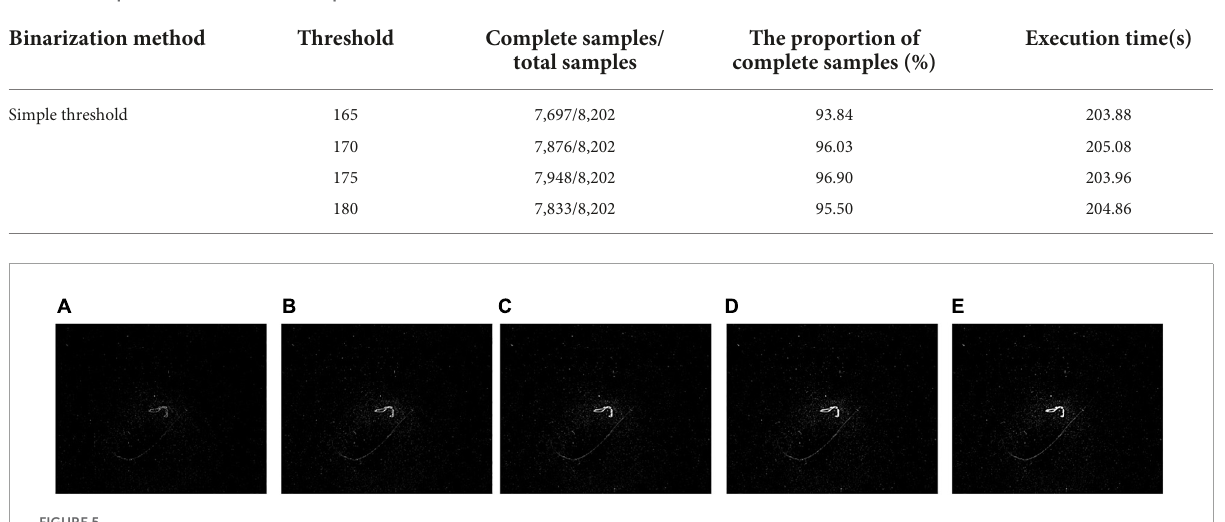
TABLE 1 Simple threshold binarization performance evaluation table.